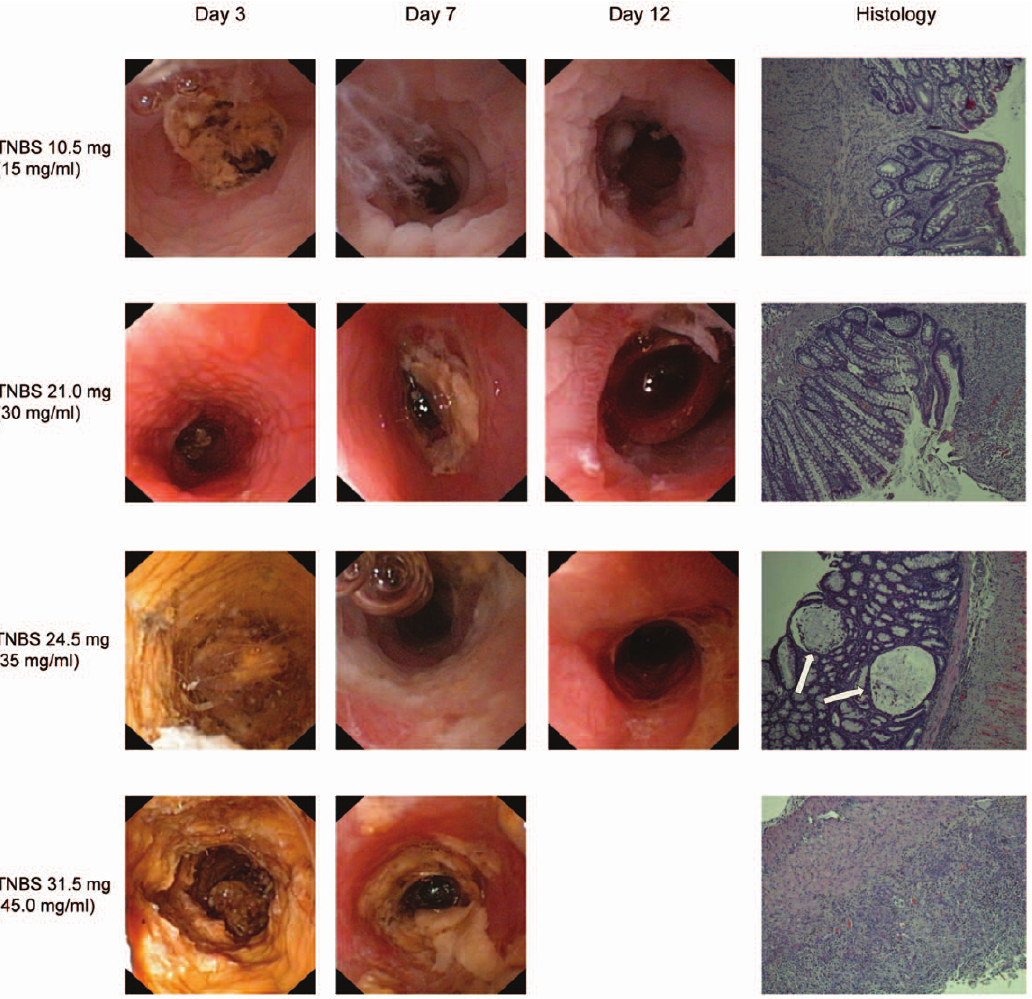
Figure 2. Endoscopic images demonstrating the effect of TNBS at different concentrations instilled rectally in a total volume of 0.7 ml. TNBS 10.5 mg (15 mg/ml) was associated with minimal mucosal inflammation and edema. TNBS 21.0 mg (30 mg/ml) resulted in an erythematous and edematous mucosa at day 3 and 7. At day 12 mucosal granulation and ulcerations were seen. TNBS 24.5 mg (35 mg/ml) and 31.5 mg (45 mg/ml) resulted in a more severe acute inflammation, and at day 7, larger areas of ulceration with fibrin cover were visible. At day 12, stenotic strictures developed in the rat receiving TNBS 24.5 mg. The rat receiving 31.5 mg was euthanized after the second endoscopy and consequently no endoscopic picture from day 12 can be shown. In the right column, histological pictures corresponding to mild, moderate and severe TNBS-colitis are included. TNBS 10.5 mg (15 mg/ml) resulted in only minimal inflammation with some architectural changes. TNBS 21.0 mg (30 mg/ml) resulted in ulceration that bordered the mucosa with inflammatory cell infiltration. In TNBS 24.5 mg (35 mg/ml), crypt distortion and abscesses (arrows) with mucosal and submucosal inflammatory infiltration were visible. Severe TNBS colitis is seen in the lower hitstologic picture with transmural inflammatory cell infiltration and total denudation of the mucosa. Objective x10 in all histological